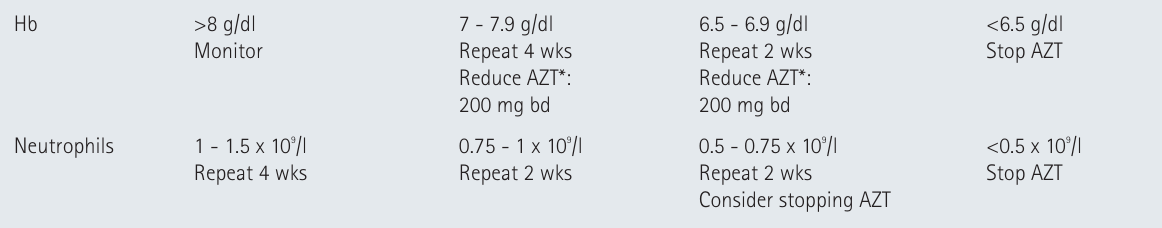
tAble Xii. GuideliNes foR MANAGiNG hAeMAtoloGicAl toXicity (MAiNly